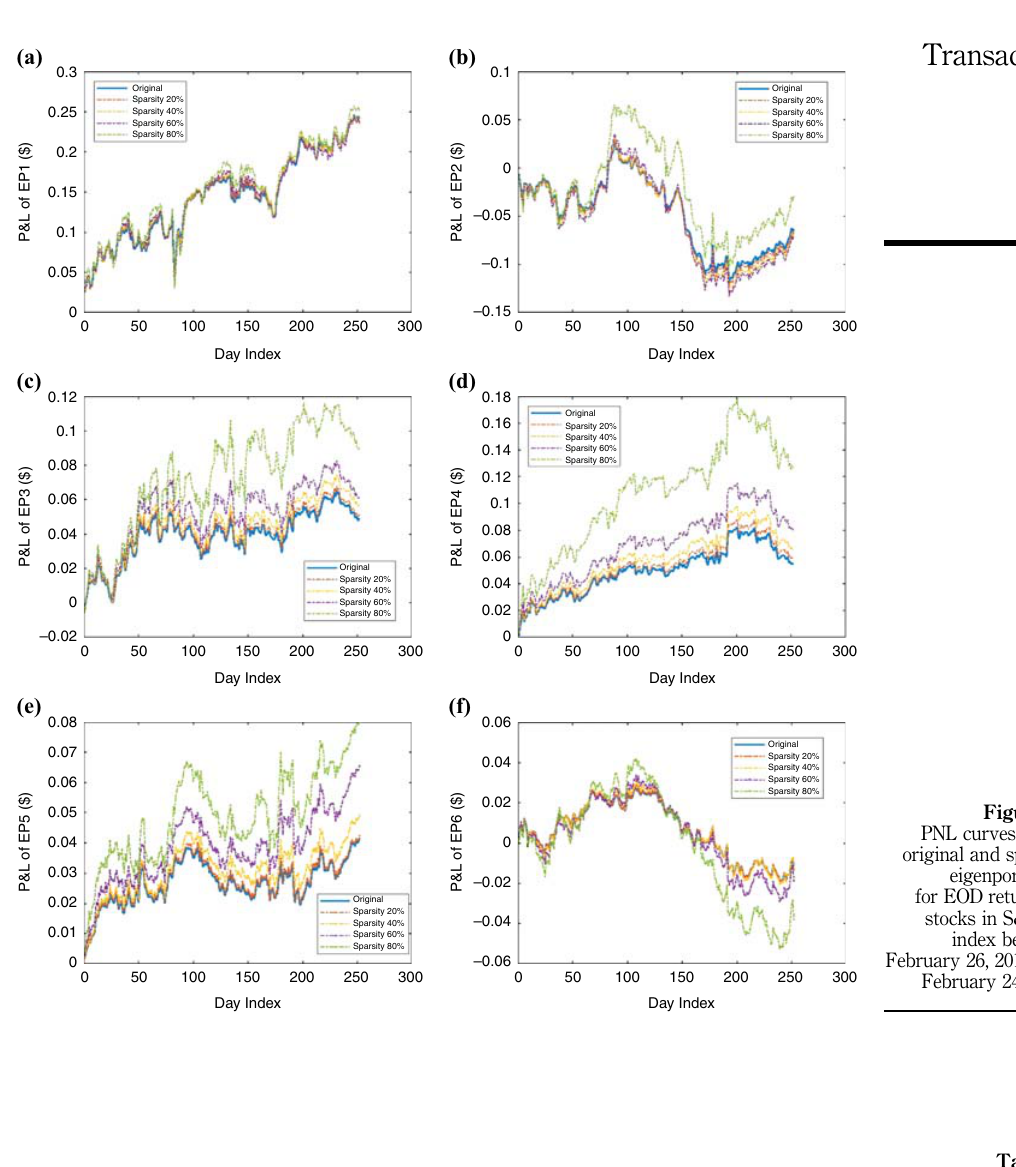
Table I. Annualized Sharpe Ratios of each eigenportfolios at different level of sparsity, using